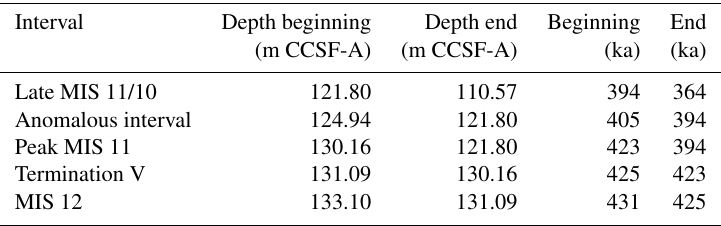
Table 2. Depths and ages of major climate intervals referred to in the text.